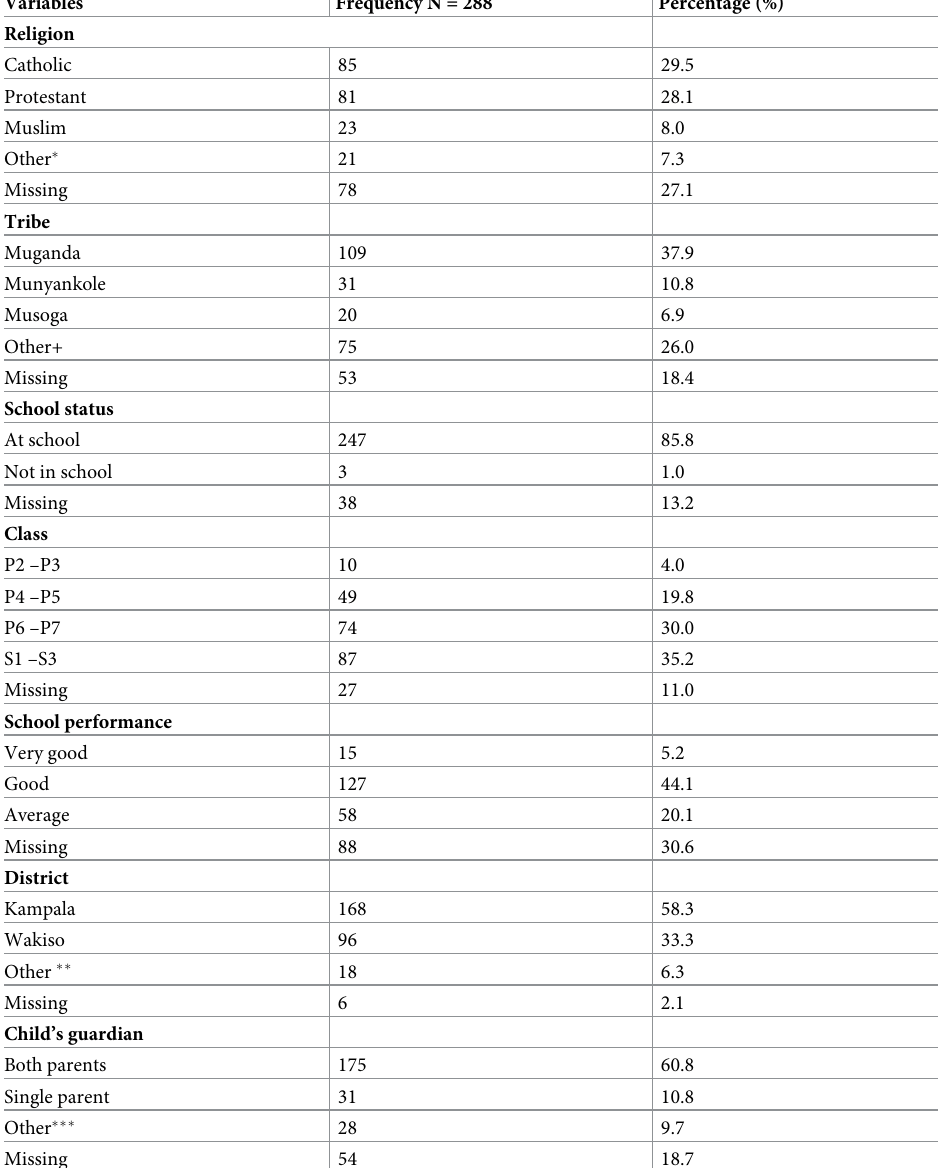
Table 2. Characteristics of 288 girls included in the study (age range 9–14 years).